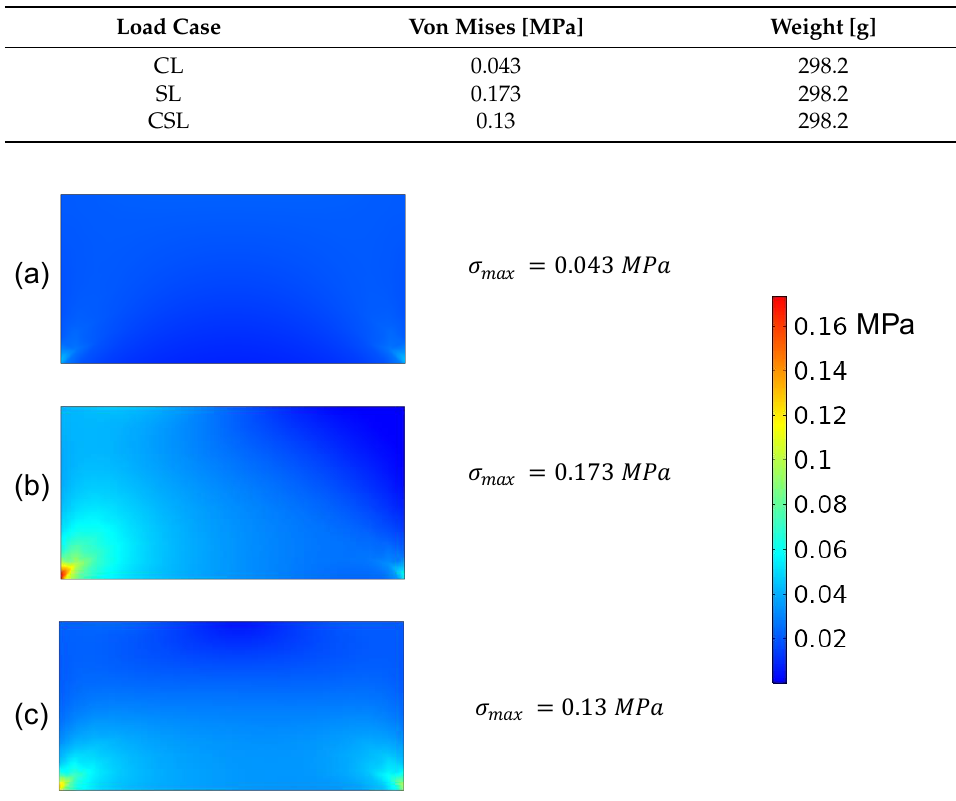
Figure 8. von Mises contours for the three load cases: ( a ) CL, ( b ) SL, and ( c ) CSL.